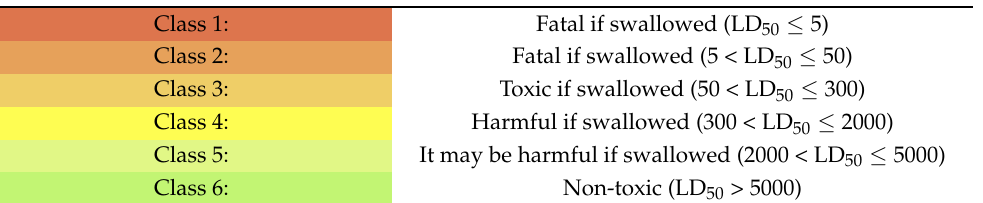
Table 9. Color code for the toxicity prediction